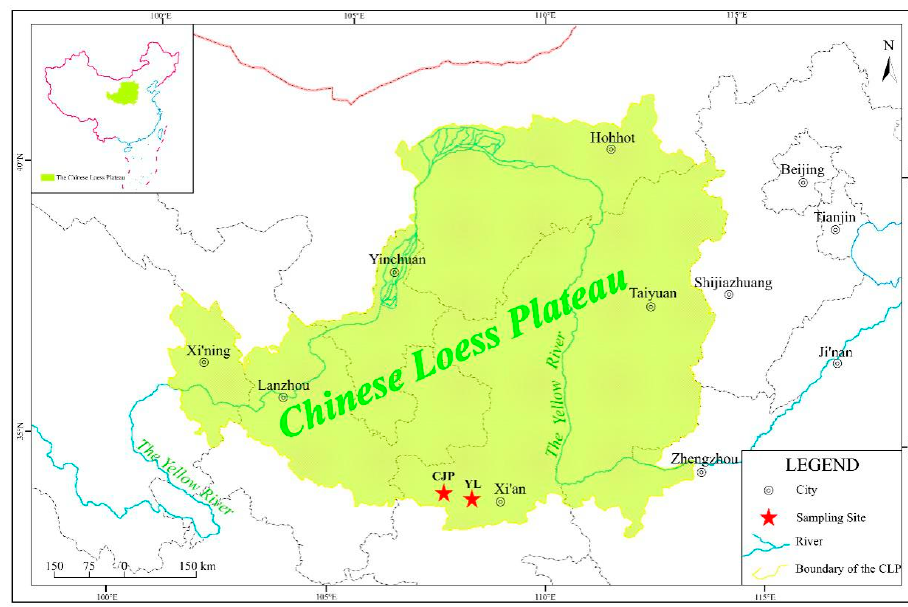
Figure 1. Location map of the study area. Yangling (YL) profile in the western part of Yangling District, and Caijiapo (CJP) profile north of Caijiapo town on southern Chinese Loess Plateau.